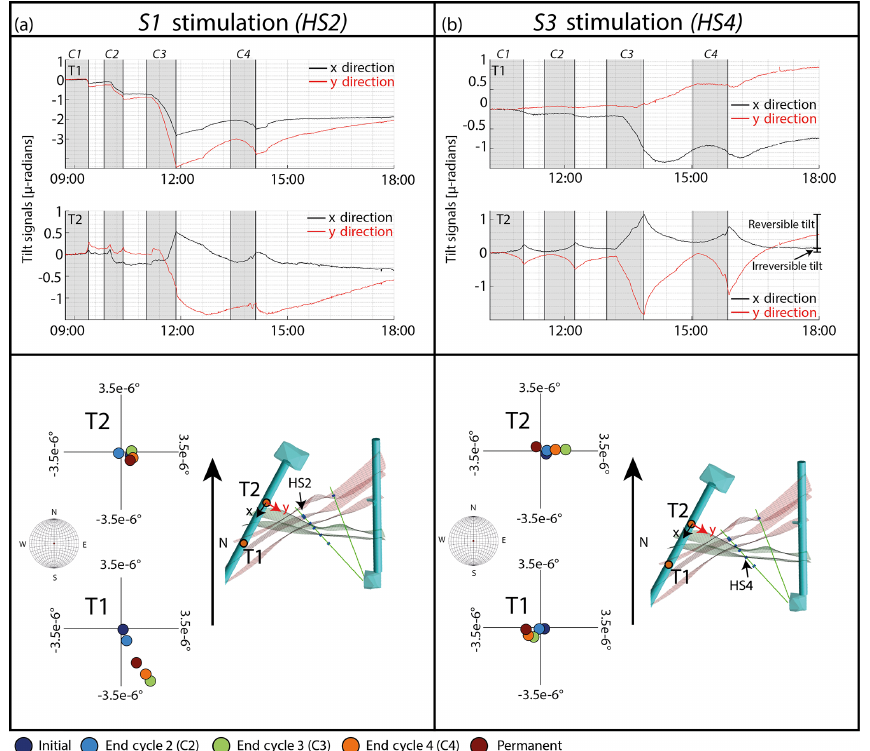
Figure 11. Inclinometer data for an S1 stimulation (HS2) (a) and S3 stimulation (HS4) (b) . The upper part of each panel shows the tilt time series for both experiments with the injection periods marked by the shaded vertical bands. The lower part of each panel shows for each experiment on the right side a horizontal cross section through the study volume at the level of the tunnels. In these sections, the shear zones, the injection locations, and tiltmeter T1 and T2 positions are indicated. The x and y axes of the tilt data are indicated on T2. Axes orientations of T1 are the same. Changes in the downward-oriented normal vector of the tunnel floor at T1 and T2 are shown in the lower hemisphere plots at the left of the frames. These frames are zoomed-in sections to the very center of the lower hemisphere stereo net. Thus, the axes appear as a Cartesian coordinate system.